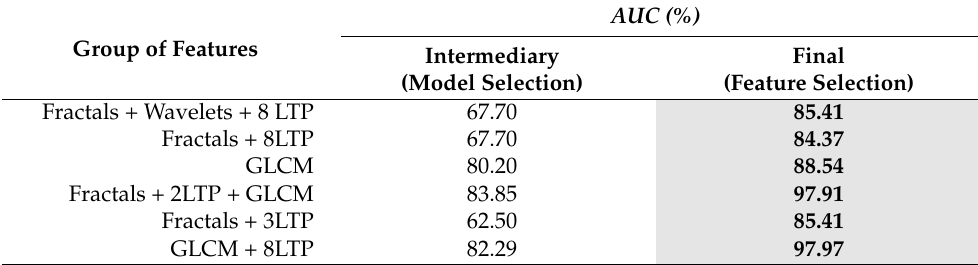
Table 9. AUC for Experiment 3: Results on model selection and on cancer